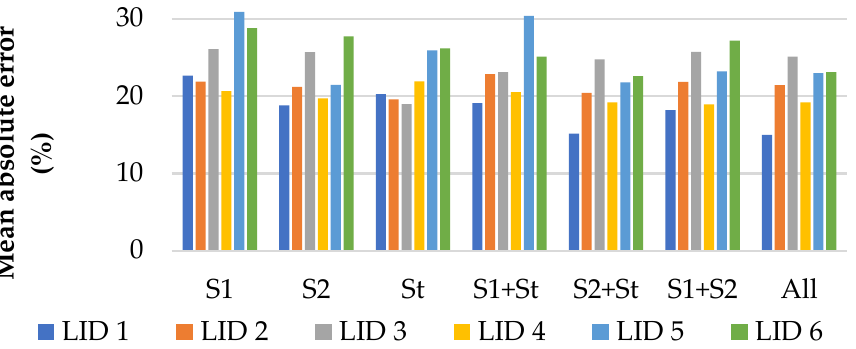
Figure 5. LFMC mean absolute error for each ex situ Location ID (LID 1 to 6).